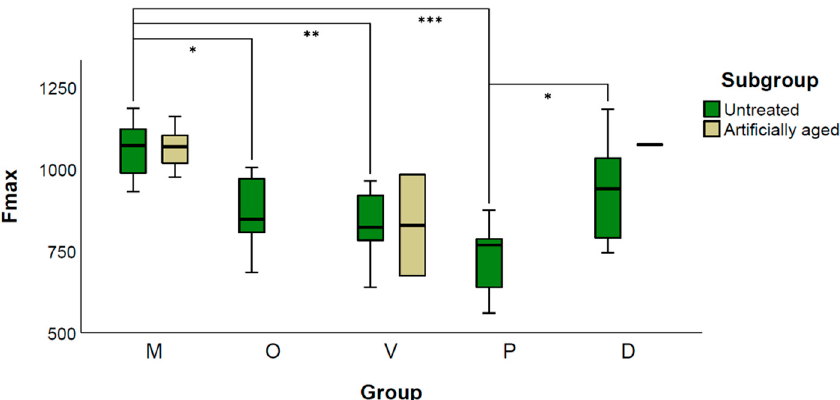
Figure 7. Grouped Boxplot of Fmax (N) of untreated and artificial loaded FDPs. Additive manufactured specimens revealed a total failure during artificial aging in group O and P, one survivor in D and two in V represented by the upper and lower limits of the box. * indicates p < 0.05; ** indicates p < 0.01, *** indicates p < 0.001.